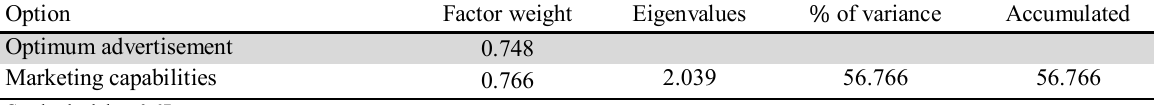
The summary of factors associated with marketing organization